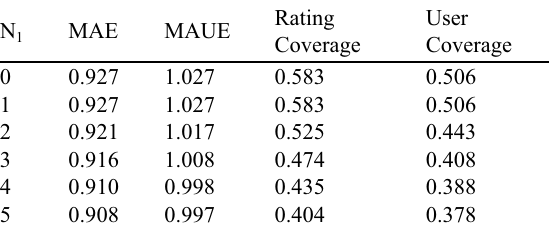
Table 4. Determine the optimized value of 1 N on Epinions.